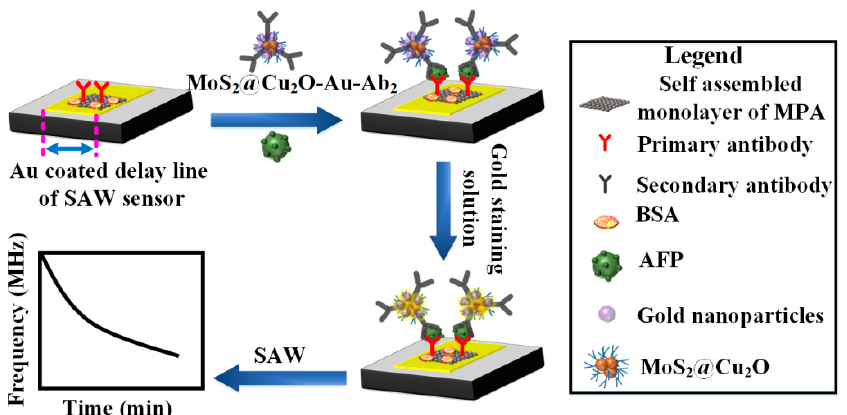
Figure 1. Schematic representation of sandwich-type SAW immunosensor for detection of